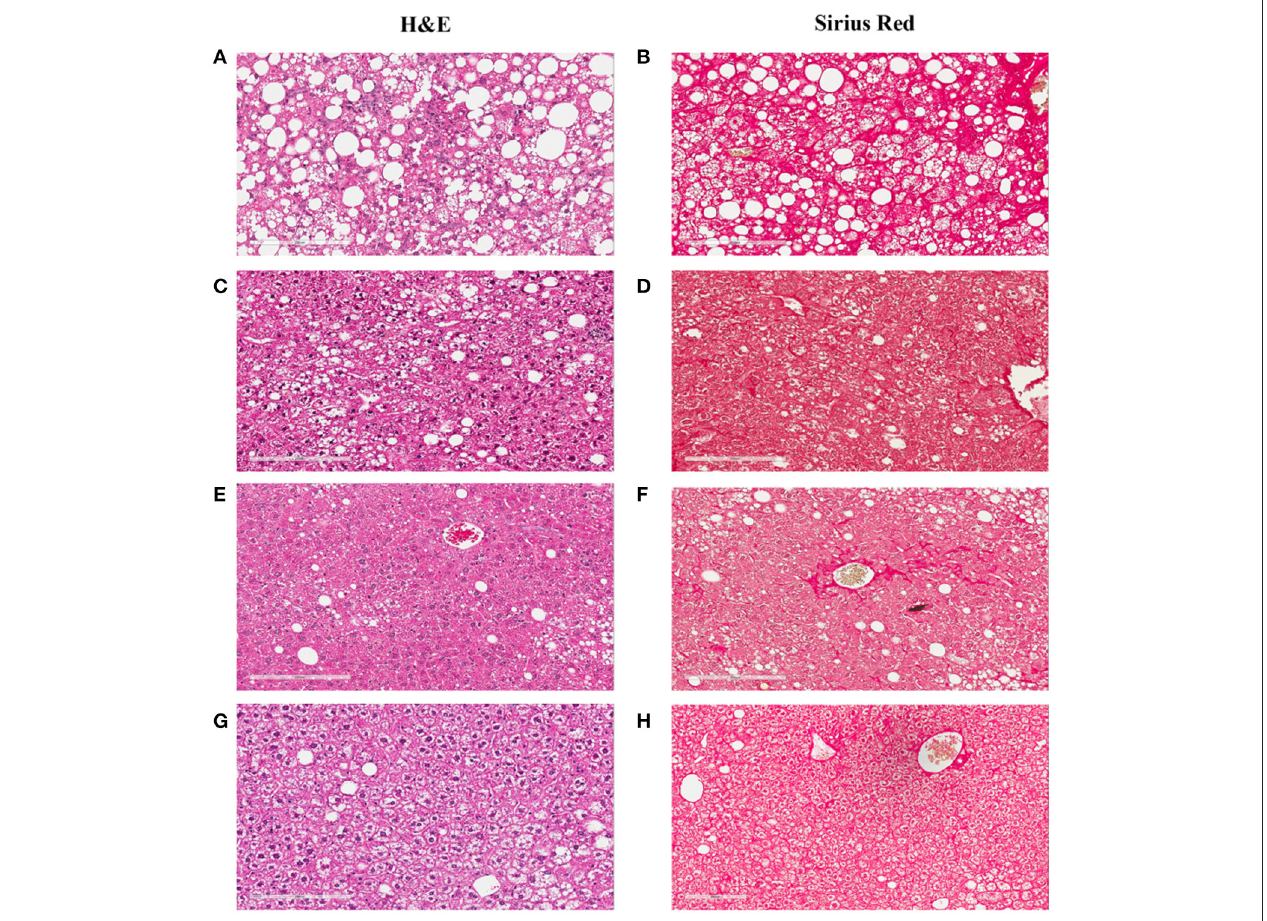
FIGURE 6 | Hepatic lesion regression after the Western diet was replaced by chow. The representative images were taken from the liver sections of the NASH mice at baseline (A,B) , or after their Western diet was replaced by rodent chow for 42 (C,D) , 84 (E,F) , and 112 (G,H) days, respectively. (A,C,E,G) are the images of the liver sections stained with H&E; Panels (B,D,F,H) are the images of the liver sections stained with Sirius Red.